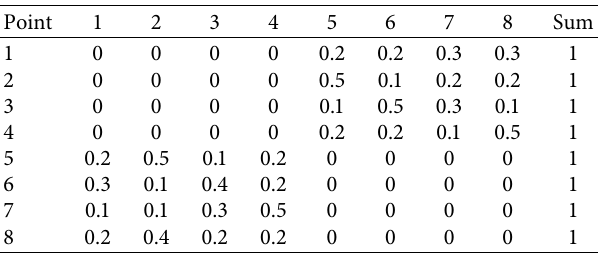
Table 2: Travel destination selection probability of